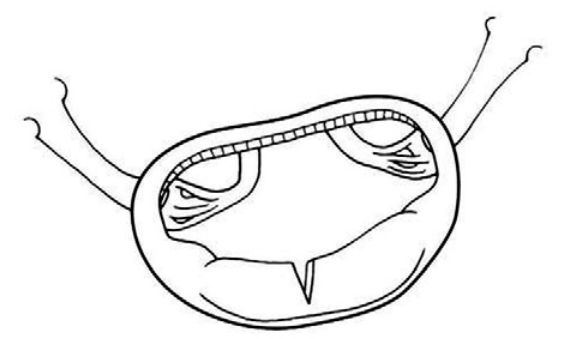
Fig. 4 - These sutures are left untied and are subsequently taken through the prosthetic valve ring along with the other valve